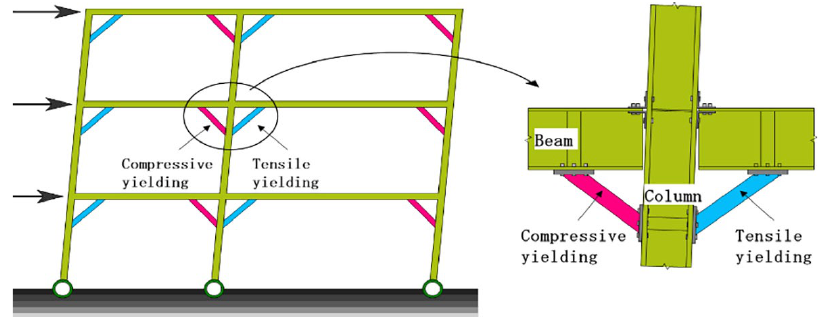
Figure 14. Steel frame with knee braces proposed in the reference